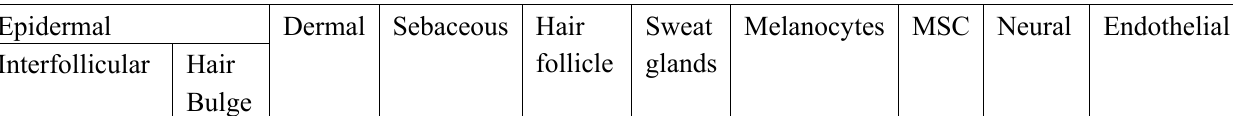
Table 2. Types of cutaneous stem